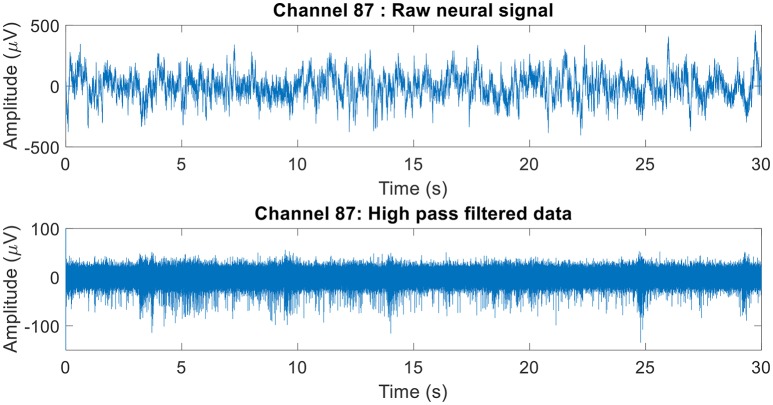
Raw neural recording on channel 87. The 30 s recording consisted of multiple different trials. The raw neural recording on each was filtered using a high-pass Butterworth of cut-off frequency 250 Hz (channel 87 was chosen at random). The MATLAB function “filtfilt” was used to filter the neural signal to ensure zero-phase distortion.